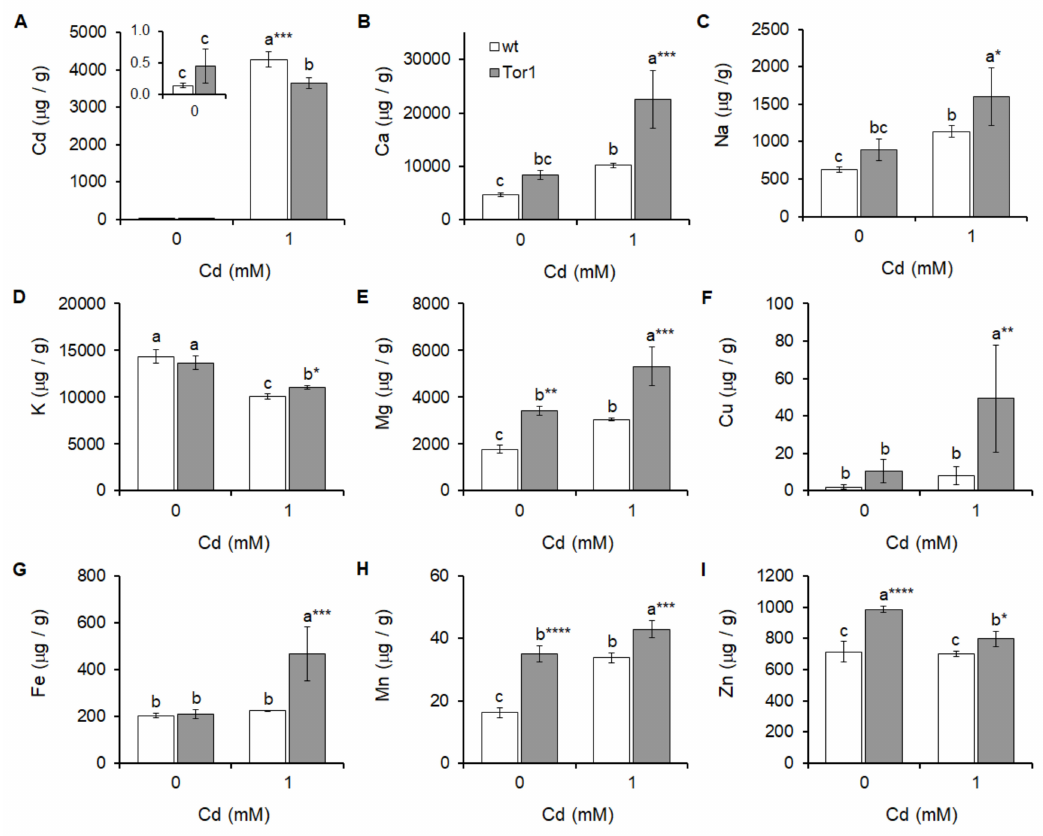
Figure 6. Ion content of wild-type (wt, white bars) and Tor1-deficient (Tor1, grey bars) cells before and after the Cd treatment. Determination of the mineral particles content by inductively coupled plasma – optical emission spectroscopy (ICP-OES) demonstrates di ff erences in the ( A ) cadmium, ( B ) calcium, ( C ) sodium, ( D ) potassium, ( E ) magnesium, ( F ) copper, ( G ) iron, ( H ) manganese, and ( I ) zinc amounts of untreated or Cd (1 mM)-treated wt and Tor1 cells. Statistical significance determined by Duncan´s post-hoc test is expressed with an asterisk (*) and set up as p < 0.05 *, 0.01 **, 0.001 ***; identical letters above bars indicate no significant di ff erences between the two values, white bars represent the mean ± SD of wild-type cells, grey bars represent the mean ± SD of Tor1-null cells ( n =